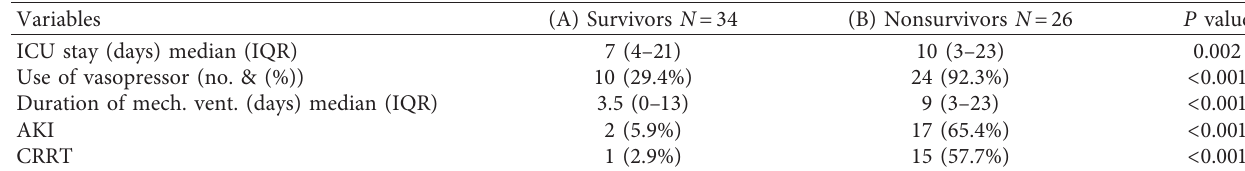
Table 3: Outcome data in the two study